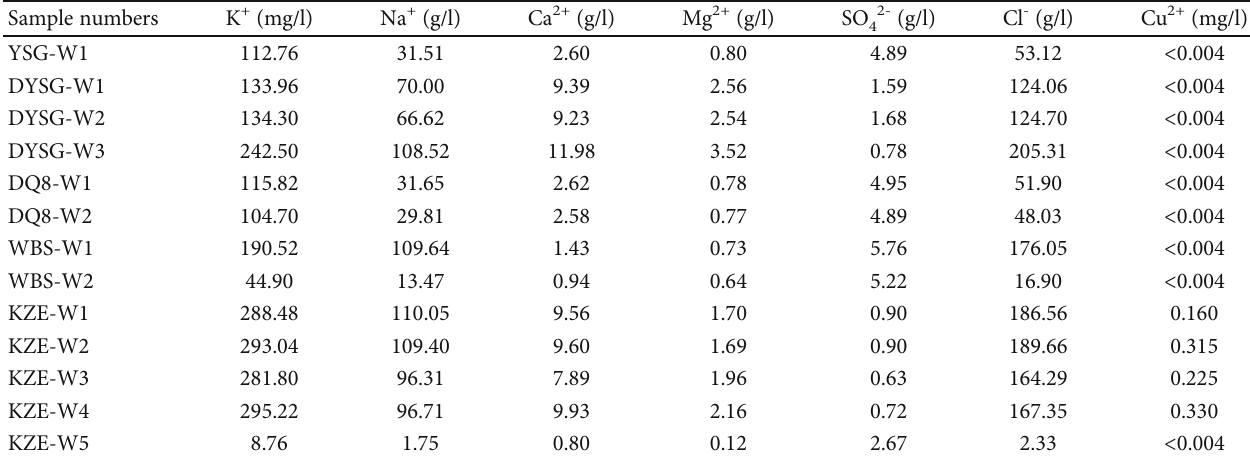
Table 5: Main chemical components of the surface brine.